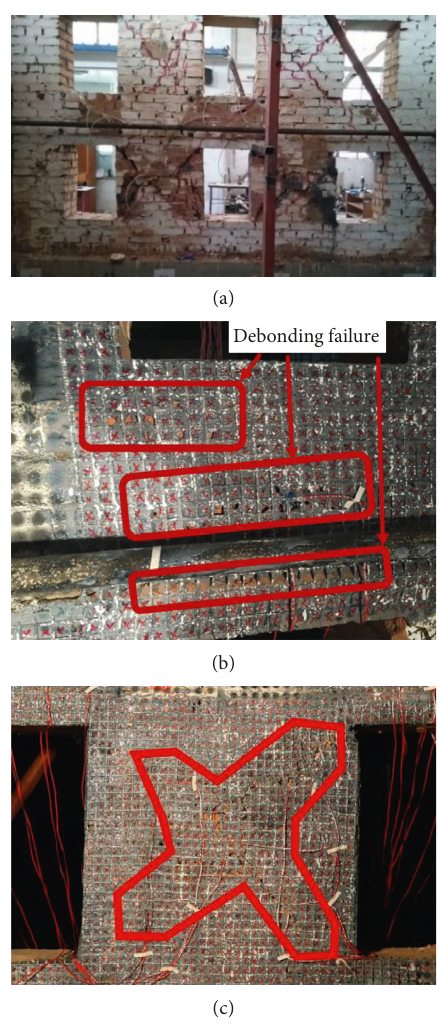
Figure 9: Failure details of CRM wall. (a) Failure of the CRM wall from the north side. (b) Debonding failure in 2-CD region. (c) Debonding failure in 1-B